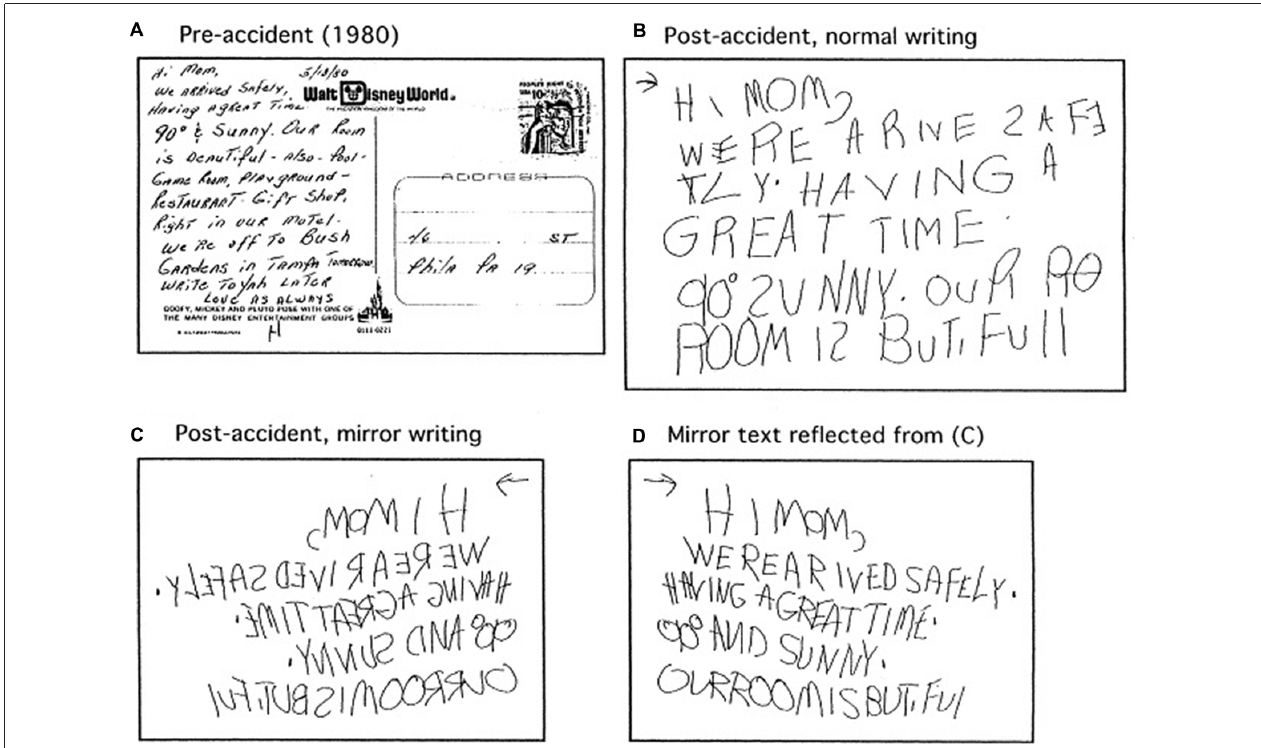
FIGURE 4 | Examples of normal and mirrored writing by a woman following a cardiovascular accident (from Gottfried et al., 2003). (A) Writing before the accident. (B) Normal writing after the accident. (C) Mirror writing after the accident. (D) Mirror writing after the accident shown left-right reflected. Permission to reproduce by agreement between MCC and Elsevier, license number